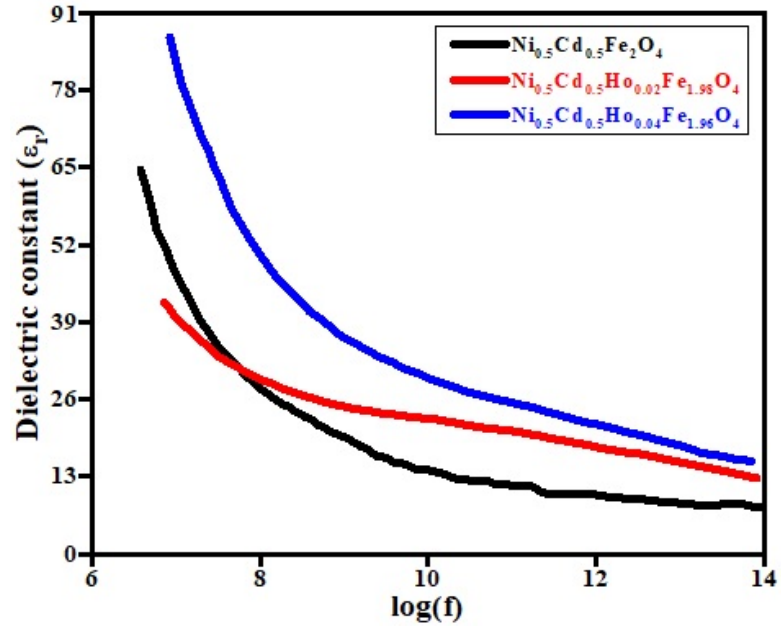
Figure 4. The dielectric constant vs. log(f) plot for Ni 0.5 Cd 0.5 Ho x Fe 2-x O 4 (x = 0, 0.02, and 0.04).